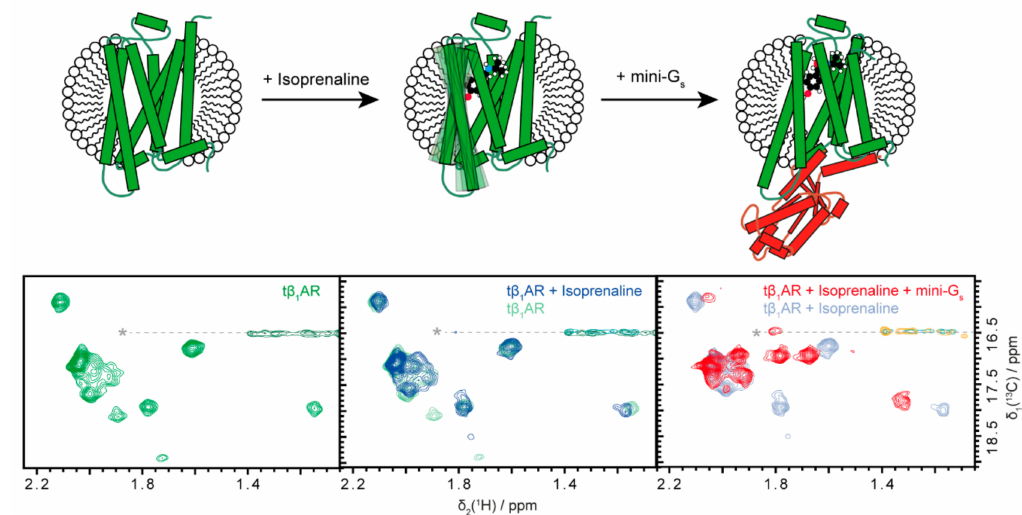
Figure 3. Crucial steps of the signaling pathway monitored by nuclear magnetic resonance (NMR). Shown is t β 1 AR-TS in its resting state without any ligand (left), after addition of the agonist isoprenaline (ball and stick model, middle) and after addition of the G protein surrogate mini-G s (red, right). Spectra of the respective states, recorded under the same conditions as in Figure 2, are shown below each cartoon. While agonist binding only leads to small changes in the spectrum, binding of mini-Gs induces lager conformational changes a ff ecting the entire receptor. 1 mM isoprenaline and 4 mM ascorbate were added to obtain the agonist-bound state. The complex with mini-G s was formed by addition of a stochiometric equivalent of mini-G s to the agonist-bound